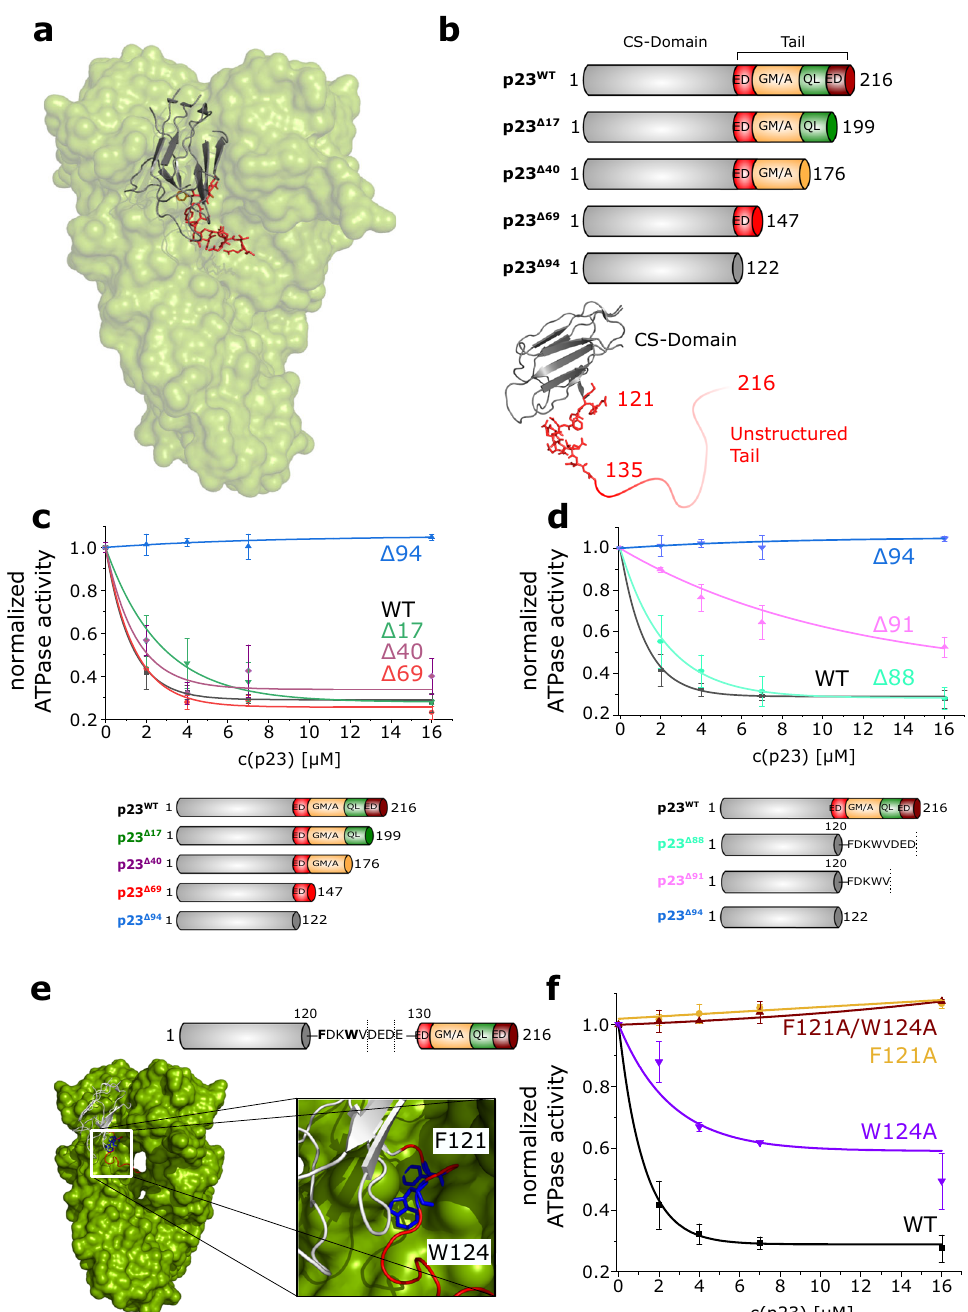
Fig. 1 p23-mediated inhibition of the Hsp90 ATPase activity depends on F121 and W124. a The crystal structure of yeast p23 (Sba1) bound to yeast Hsp90 (Hsp82) is shown (PDB: 2CG9). The p23 CS domain is depicted in gray, the part of the p23 tail that was resolved in the crystal structure is shown in red. b The schematic domain architecture of p23 and the truncation mutants used in this study are shown. A close-up view of the p23 molecule is shown at the bottom (PDB: 2CG9). ED = negatively charged stretch; GM/A = GM/A-rich region; QL = QL-rich region; ED = second negatively charged stretch. c – f All sub fi gures show ATPase assays in the presence of WT or mutant yeast p23 (Sba1). The ATPase activity of yeast Hsp90 (Hsp82) was determined in the presence of rising p23 concentrations. WT (black) is shown as a reference in all fi gures. c , d Effects of the deletion mutants p23 Δ 17 , p23 Δ 40 , p23 Δ 69 and p23 Δ 94 on the ATPase activity of Hsp90. Note that the same data set was used for p23 WT and p23 Δ 94 in ( c ) and ( d ) as a reference. e Top: the p23 domain architecture is shown and the F 121 DKW 124 VD motif is highlighted. Bottom: crystal structure of p23 (gray cartoon) bound to the Hsp90 dimer (green surface) (PDB: 2CG9). The p23 CS domain is shown in gray, the tail region (up to aa 135) is depicted in red and the F121 and W124 residues are shown in blue. f Effect of the point mutants p23 F121A , p23 W124A and the double mutant p23 F121A/W124A on the inhibition of the Hsp90 ATPase. Note that the WT data from ( c ) and ( d ) were plotted as a reference. Bars and errors represent means ± SD of triplicate